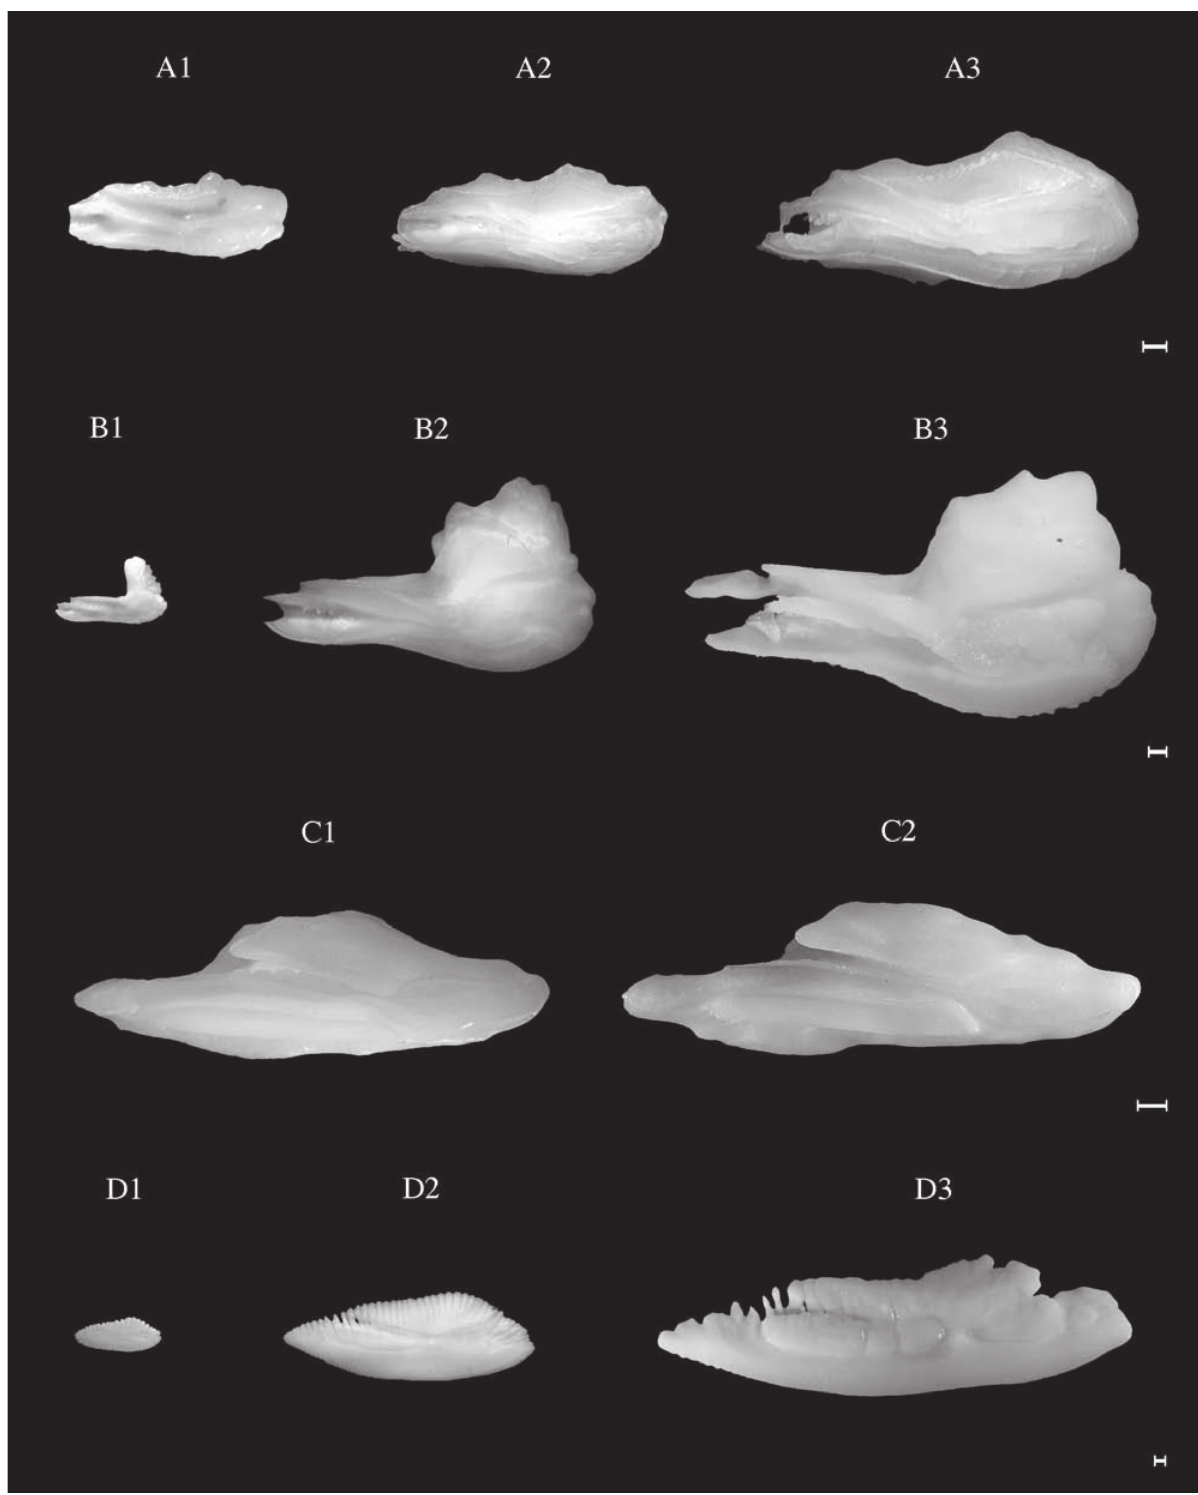
Fig. 28. – Lepidion lepidion (WM). TL: A1, 13.0 cm; A2, 20.0 cm; A3, 29.8 cm. Mora moro . TL: B1, 7.5 cm (WM); B2, 43.0 cm (WM); B3, 73.0 cm (CEA). Physiculus dalwigki (CEA). TL: C1, 22.5 cm; C2, 27.5 cm. Merluccius merluccius . TL: D1, 15.4 cm (NEA); D2, 53.0 cm (WM); D3, 98.8 cm (CEA). Scale bar = 1